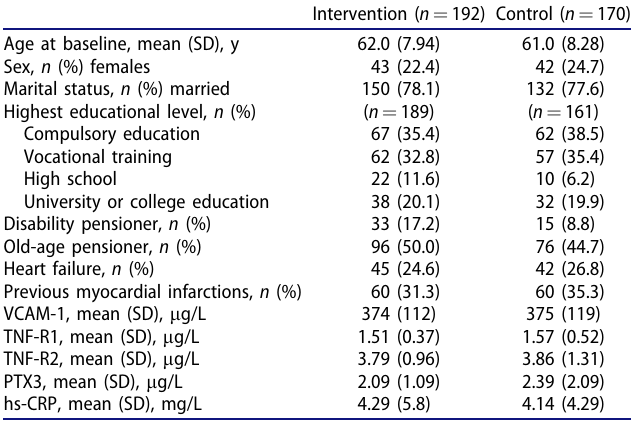
Table 1. Baseline characteristics of the study